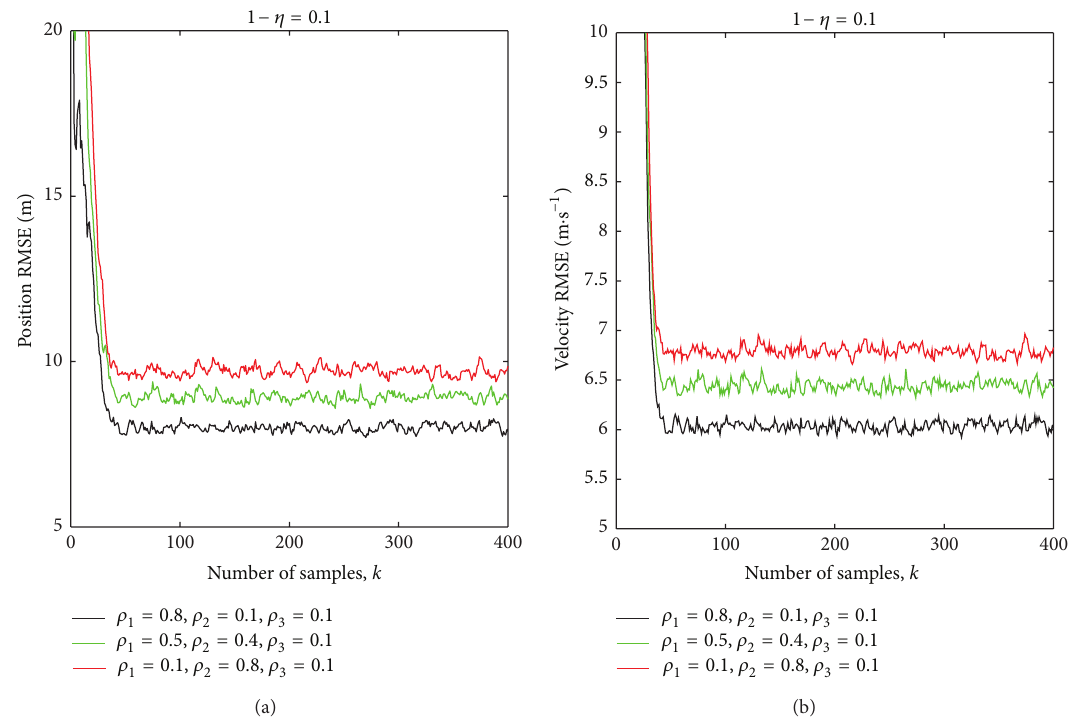
Figure 7: Comparison of the RMSEs for the proposed algorithm with different 𝜌 𝑞 (𝑞 = 1, 2,3) : (a) position RMSE; (b) velocity RMSE.